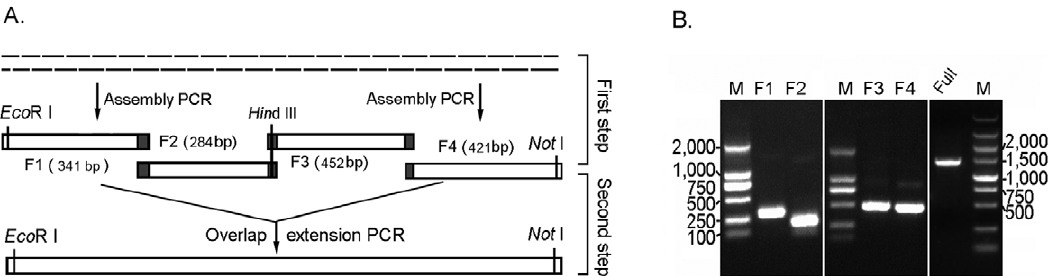
Figure 5. Schema of the two-step phyA gene synthesis method. Full length phyA gene was divided into four fragments (F1, F2, F3 and F4) with the end overlapped with each other and assembled by assembly PCR separately. In the second step, these four fragments were assembled into a full length gene by overlap extension PCR (A). (B) PCR products of F1, F2, F3, F4 and full-length phyA gene.